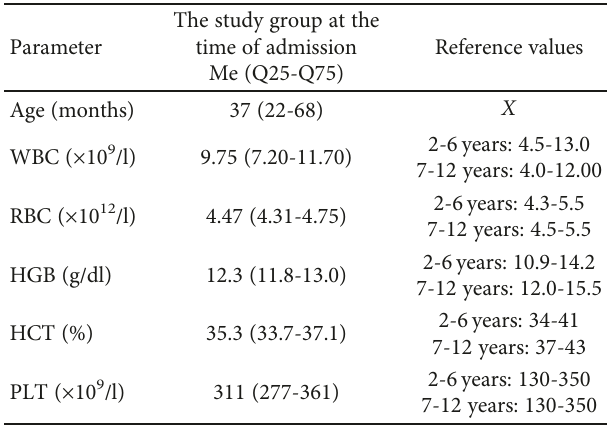
Table 1: Results of the routine investigations for the study group (children su ff ering from pseudocroup